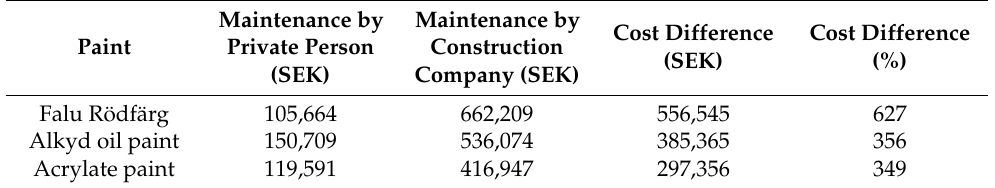
Table 6. Comparison of maintenance costs of a painted wooden facade over its working life done by private persons and companies.